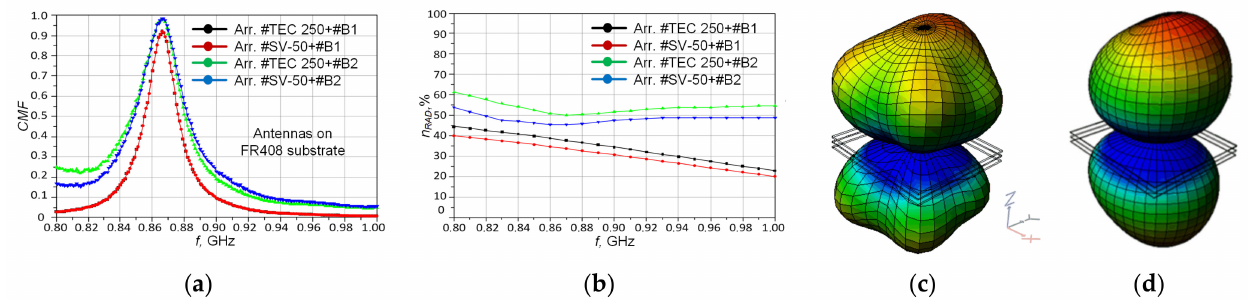
Figure 15. Parameters of RFID antennas: ( a ) CMF; ( b ) Radiation efficiency n RAD ; ( c ) Radiation pattern ( f 0 = 866 MHz) of antenna #B2 in the arrangement of #SV-50; ( d ) Radiation pattern ( f 0 = 866 MHz) of antenna #B2 in the arrangement of #TEC 250. The radiation pattern of antenna #B1 is very similar.